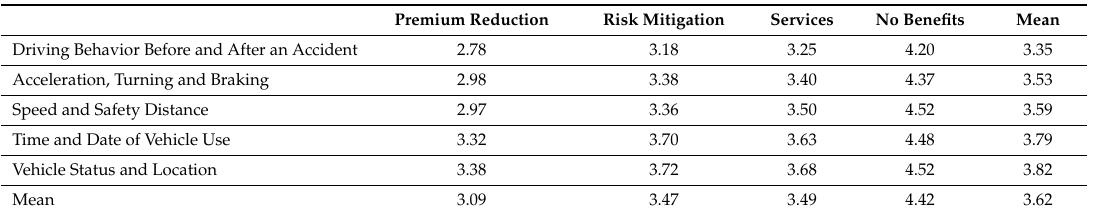
Table 3. Willingness to share information by type of information and benefit o ff ered (lower number = higher willingness).